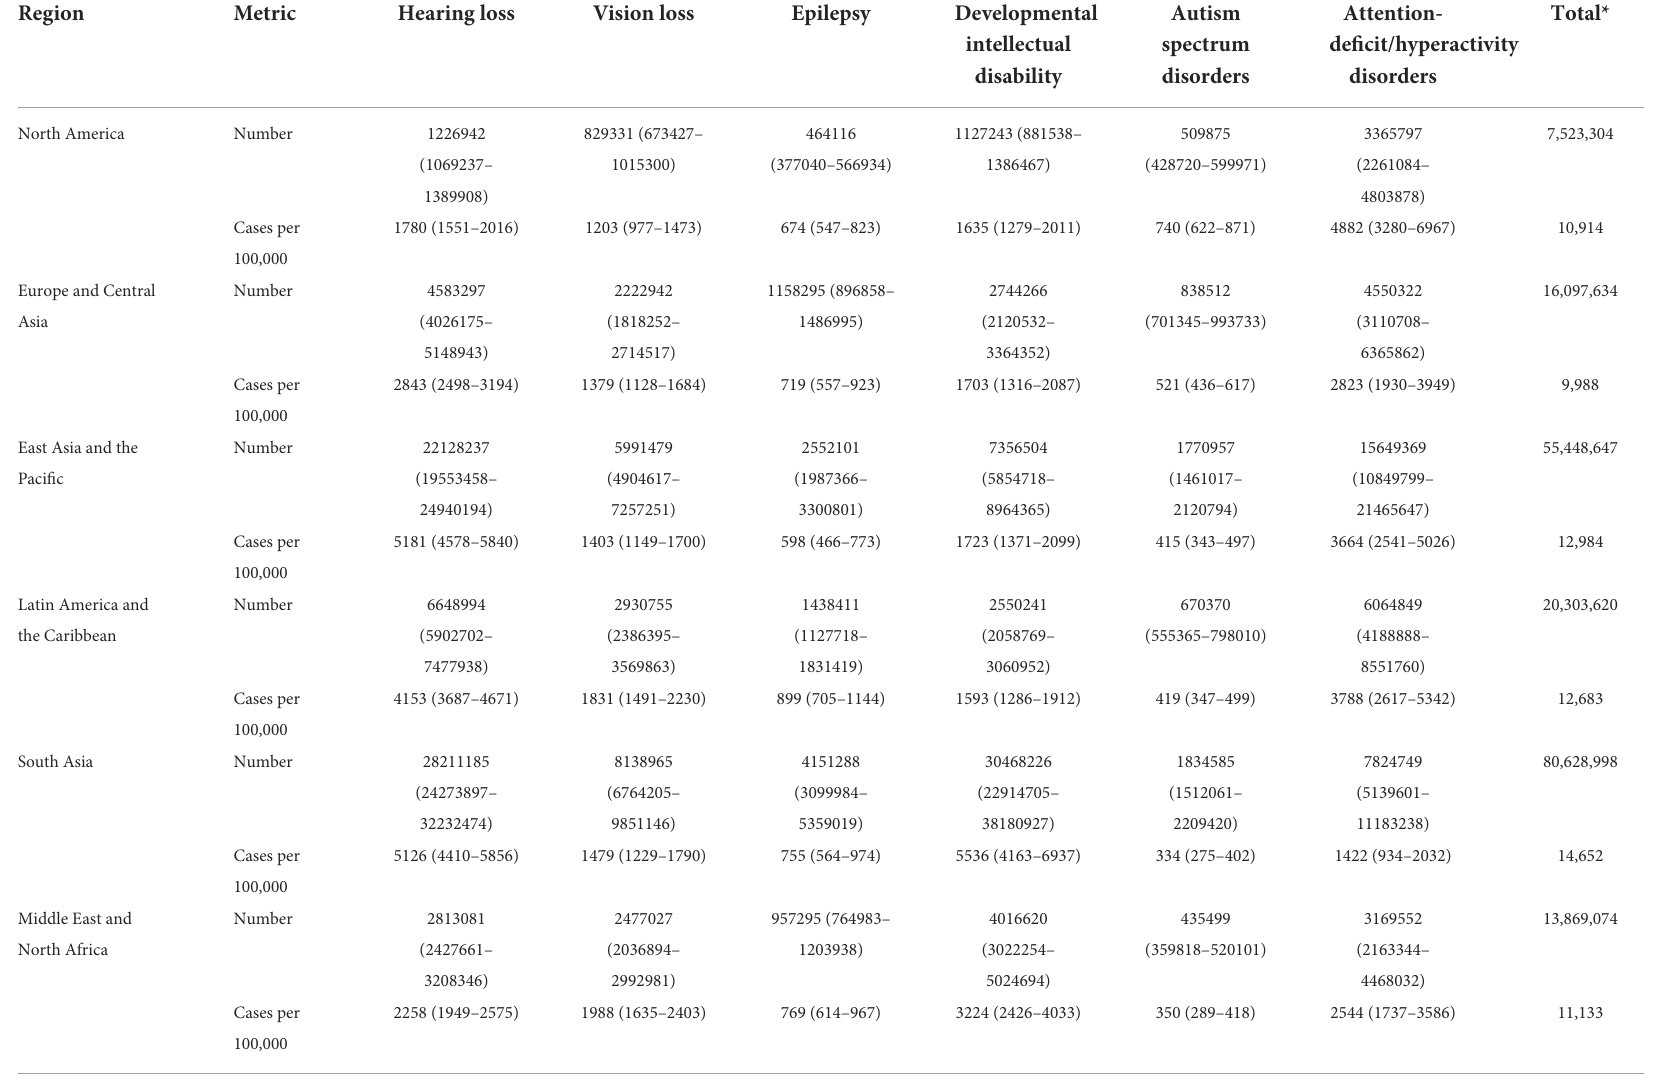
TABLE 4 Global and regional prevalence estimates (95% uncertainty intervals) of disabilities among children aged 5 to 19 years from GBD